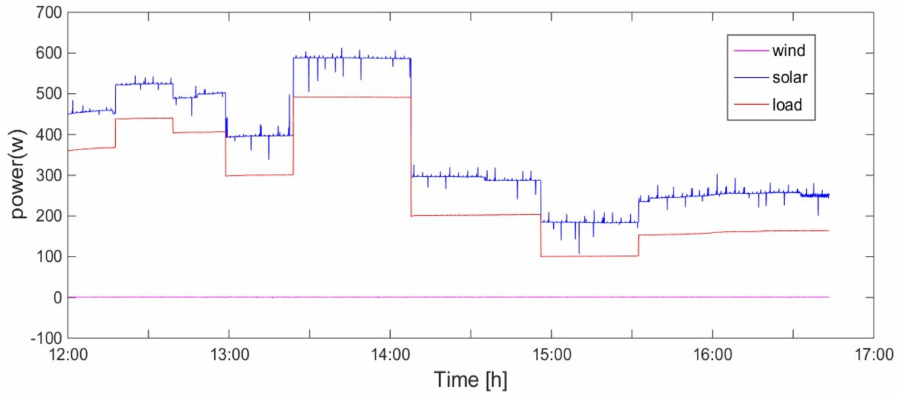
Figure 16. Power curves in scenario 4 (restricted